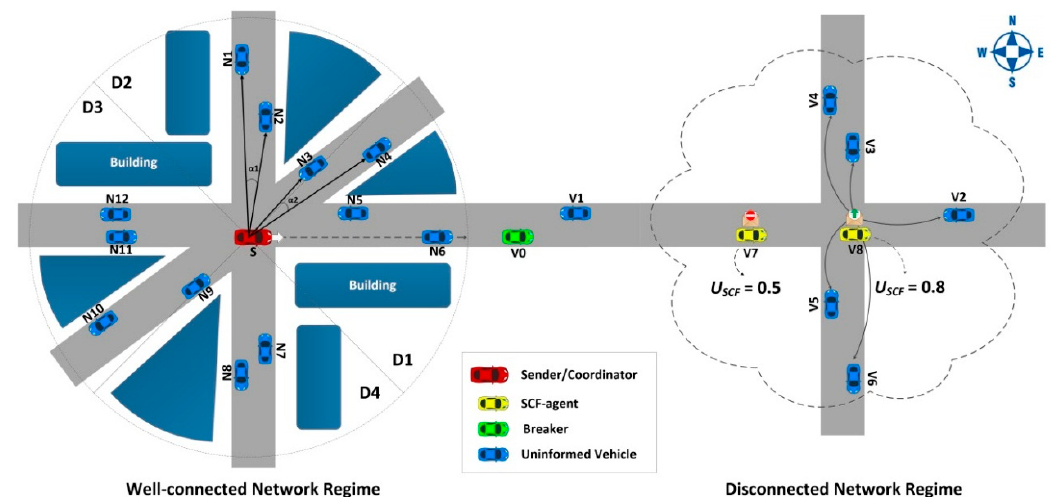
Figure 1. Illustration of the TrAD protocol.